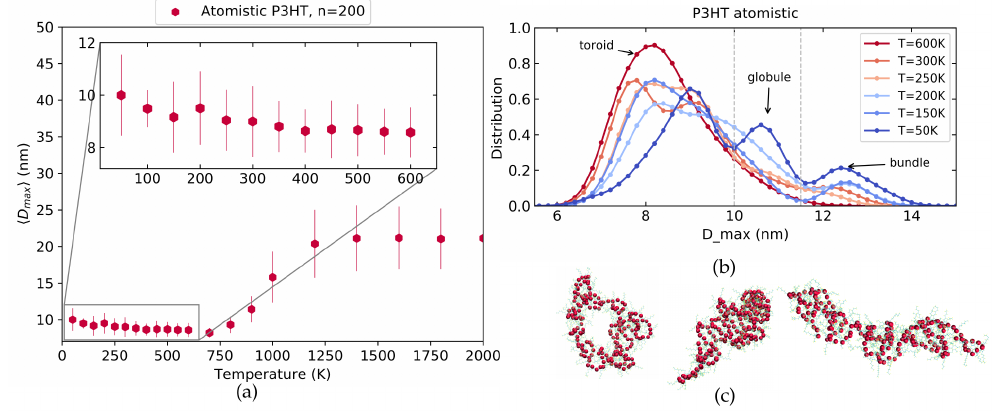
Figure 5. The maximum distance between monomers for the atomistic P3HT model in vacuum at different temperatures. ( a ) The averaged D max as a function of temperature shows a sigmoidal in- crease at very high and a slight increase towards low temperatures (inset). ( b ) The D max distributions at different temperatures exhibit three clear peaks corresponding to toroids, tight coils and bundles (from left to right) which are illustrated in ( c